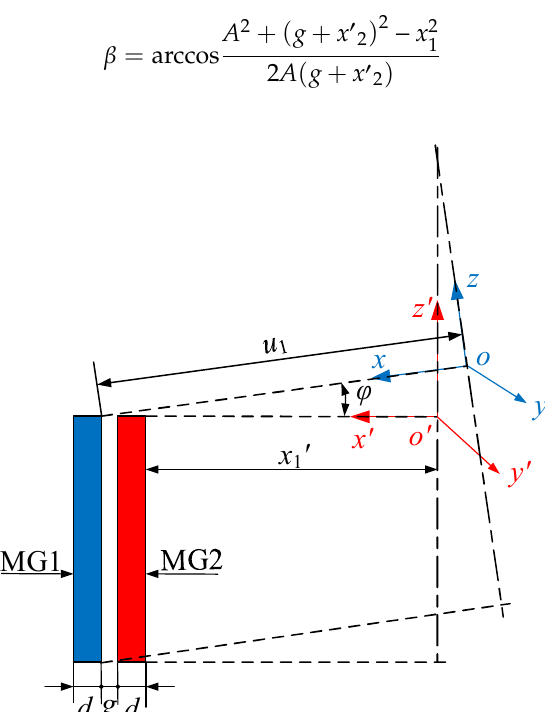
Figure 7. MG1 and MG2 in the ( o-x, y, z ) coordinate system and ( o'-x', y', z' ) coordinate system.